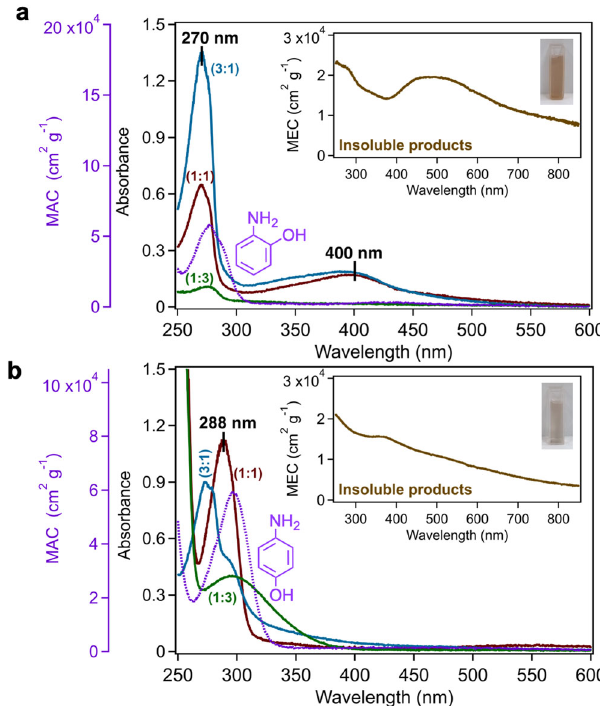
Fig. 2 Electronic properties of soluble and insoluble reaction products. UV – vis absorbance spectra for the fi ltrates following overnight reaction of ( a ) ortho -aminophenol ( o AP) and ( b ) para -aminophenol ( p AP) with Fe(III) using the same concentrations listed in Fig. 1 for different aminophenol:Fe molar ratios, (pH 3 – 4.5). The MAC spectra for the aminophenol reactants are also shown as references. The insets are the MEC spectra for diluted aqueous slurries of the insoluble solid products using